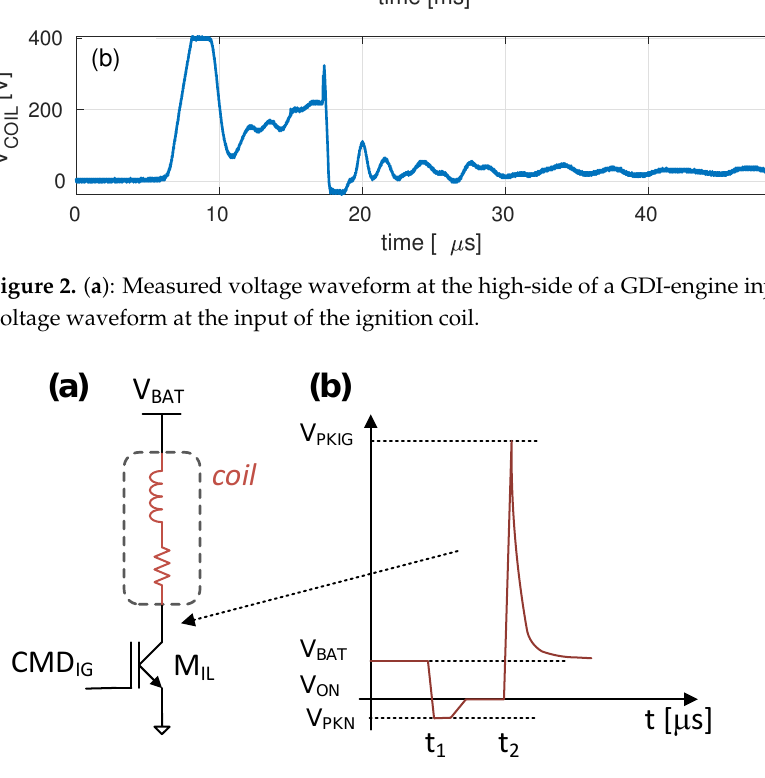
Figure 3. ( a ): IGBT-based driving circuit for ignition coil. ( b ): voltage waveform at the low-side terminal of the